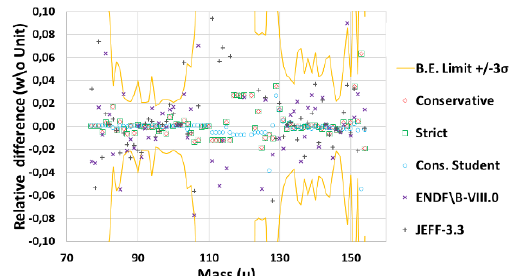
Fig. 19. Same plot as the previous one but in reference to the B.E. evaluation. The yellow lines correspond to the limits for 99.7% confidence level.